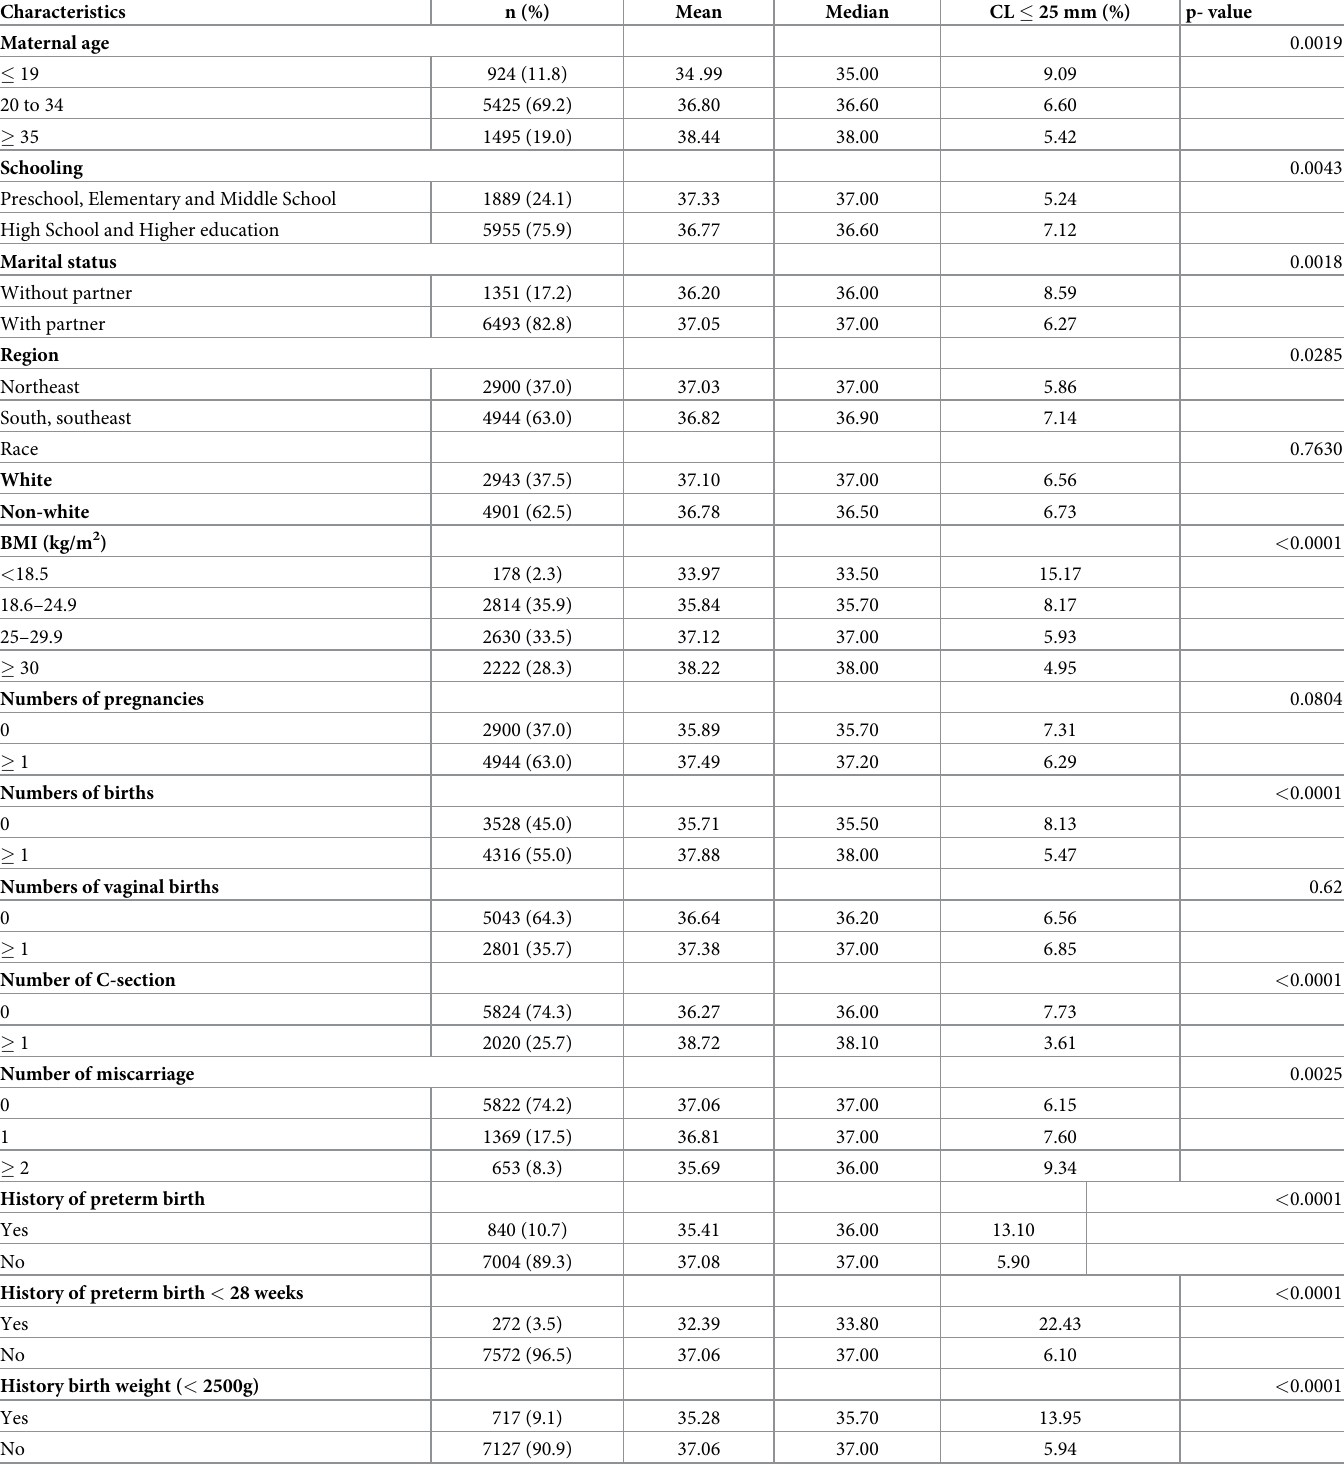
Table 1. Main sociodemographic characteristics of the sample population, mean, median of the ultrasonographic measurements in straight line of the uterine cer- vix in millimeters and percentage of cervical length � 25 mm.